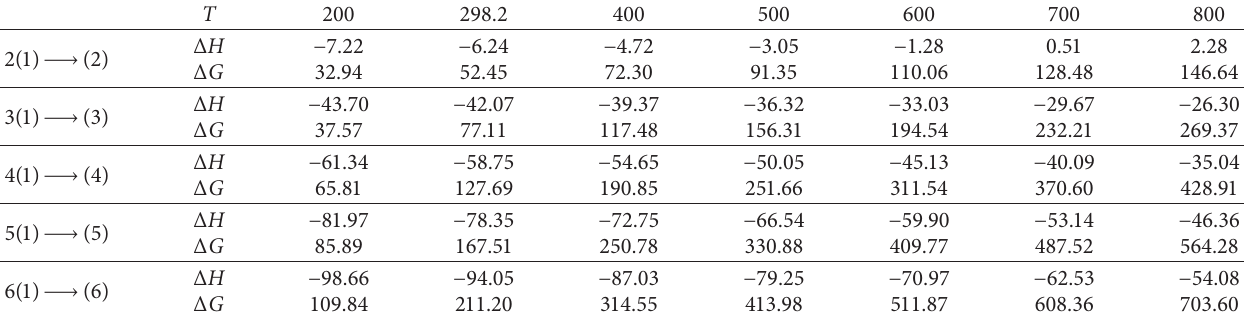
Table 5: Enthalpy change and Gibbs free energy change of oligomerization at different temperatures a